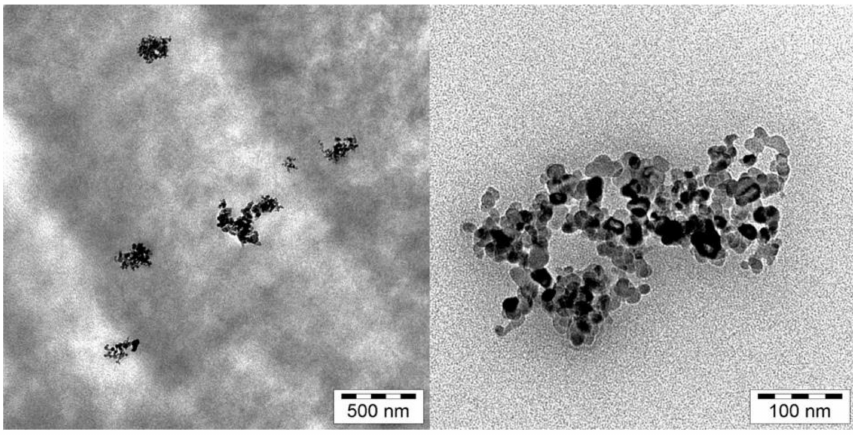
Figure 2. TEM images of a